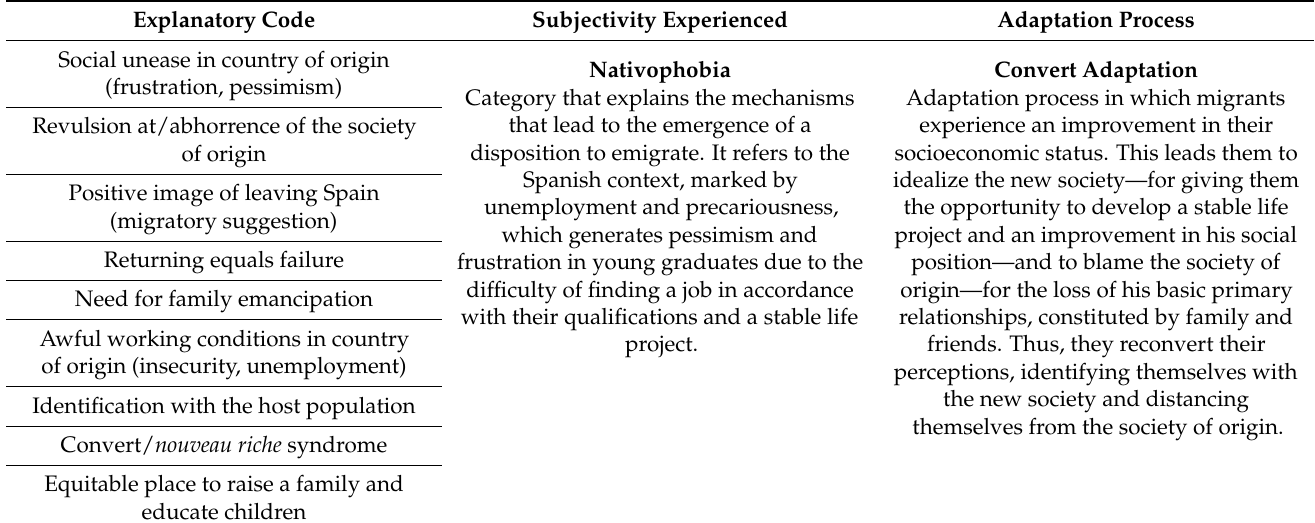
Table 1. Different types of subjectivities and adaptation